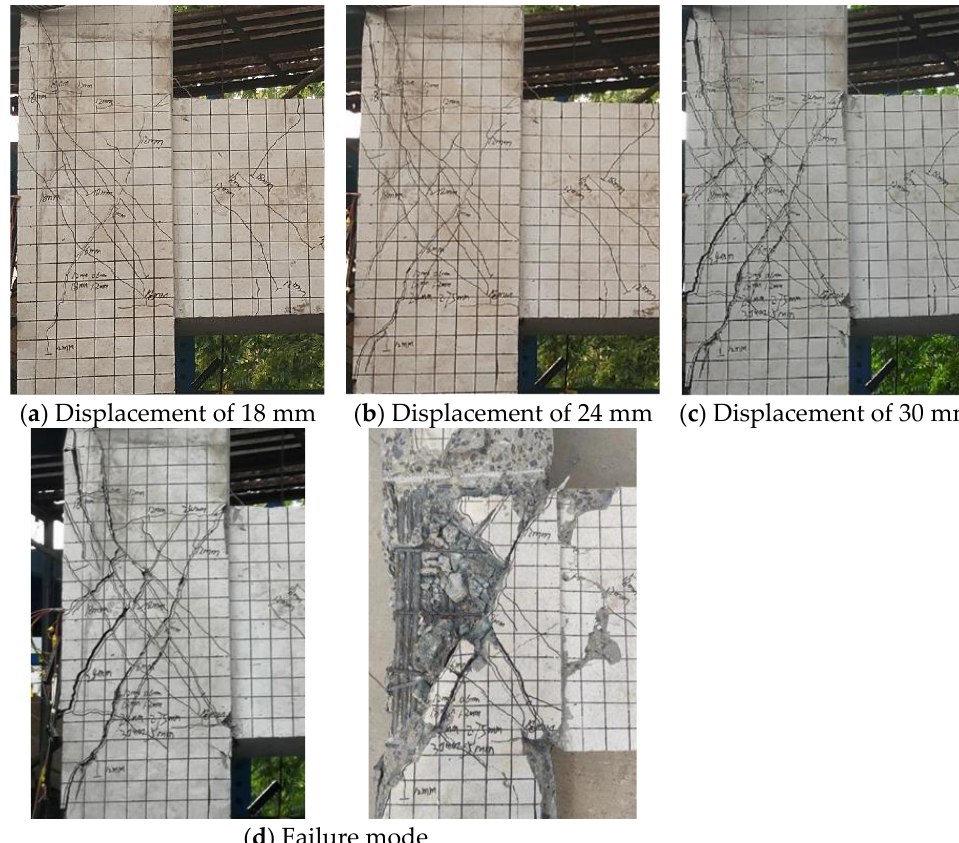
Figure 17. Crack development and failure of specimen